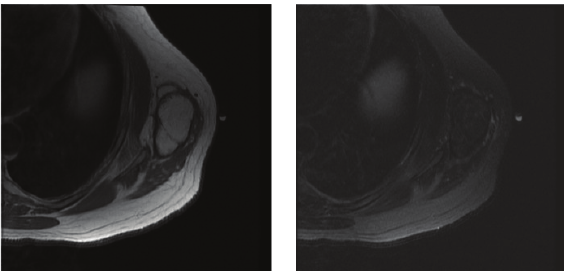
Figure 1: Axial T1 and T2 MRIs of a patient with a fatty tumor. Despite the benign appearance of this tumor radiographically, final pathological review confirmed a diagnosis of low-grade liposar- coma.